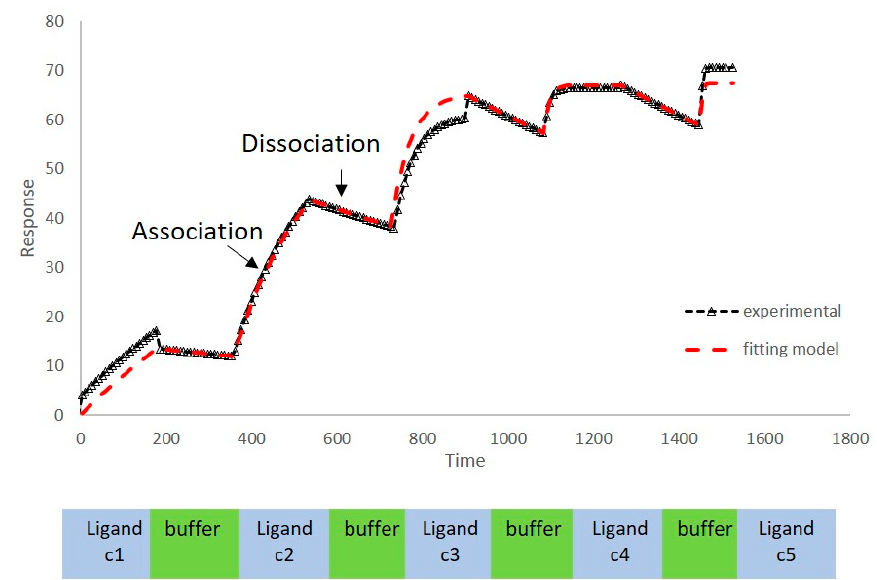
Figure 1. Sensorgram of EGCG binding to VEGF; black triangle—experimental sensorgram; and red line—fitting model. c1–c5 denote ligand concentrations 1 (lowest) to 5 (highest). Table 1. Kinetic values of the association rate constant k a , dissociation rate constant k d , equilibrium constant K D in PBST at 37 °C and IC 50 [1] for different polyphenols k a (1/Ms) k d (1/s) K D (M) IC 50 (µM)